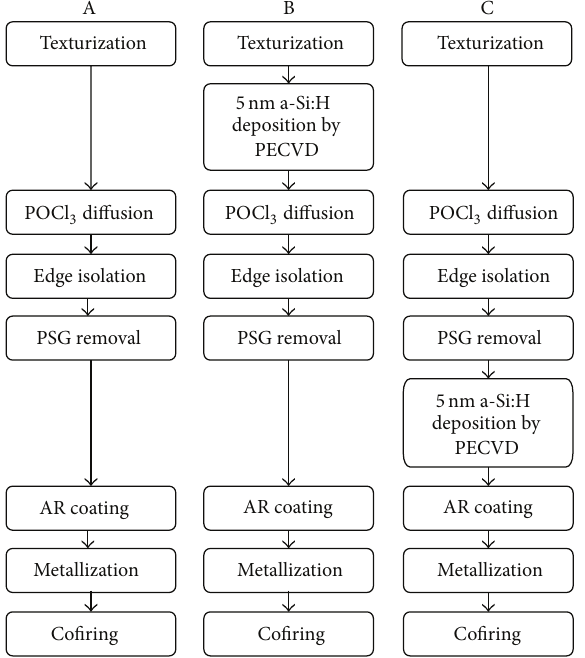
Figure 1: Process flow diagram for three groups of solar cells fabricated in this study. A, B, and C denote, respectively, the main fabrication steps for the three different groups.